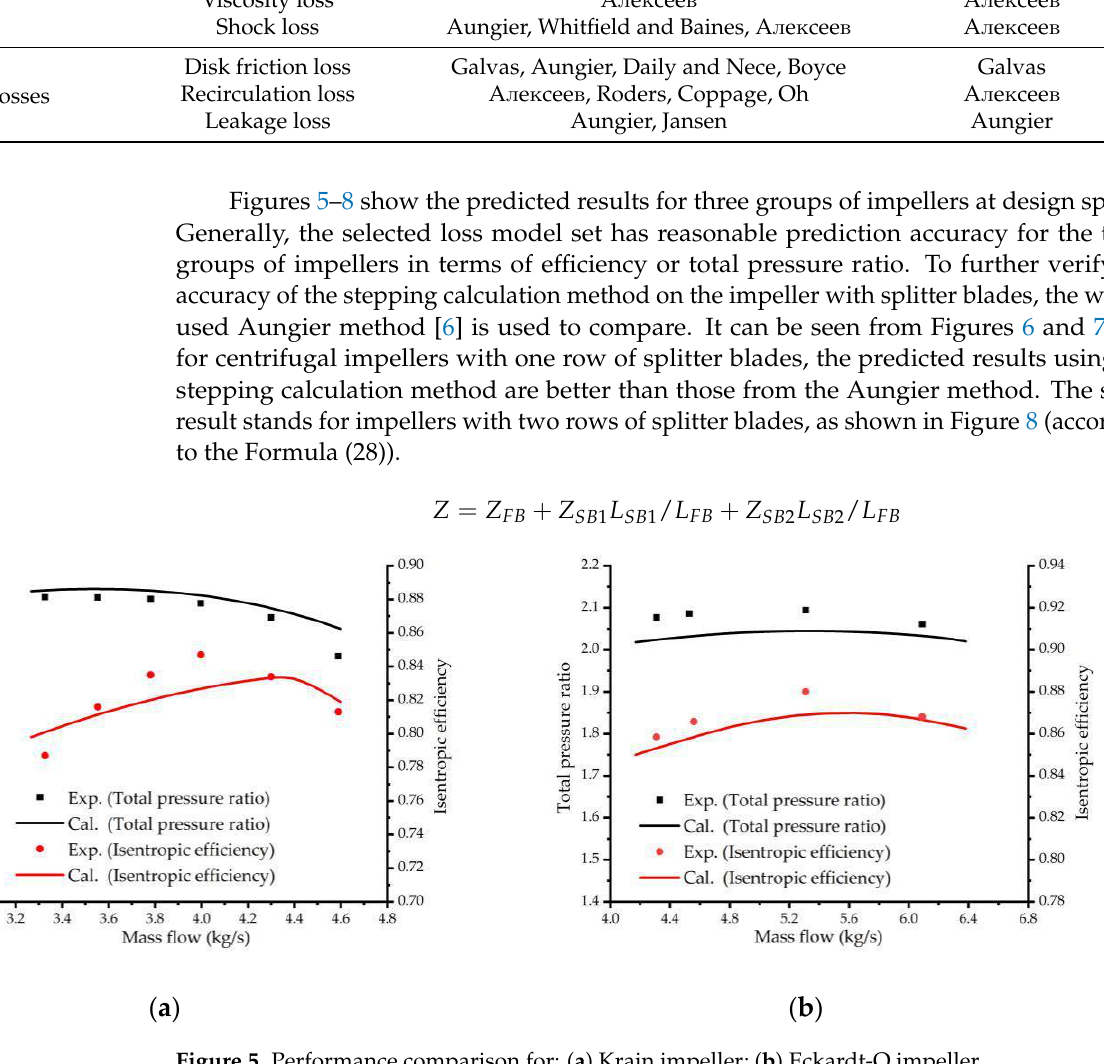
( b ) Figure 6. Performance comparison for two methods for the SRV2-O impeller: ( a ) Total pressure ra- tio; ( b ) Isentropic efficiency .